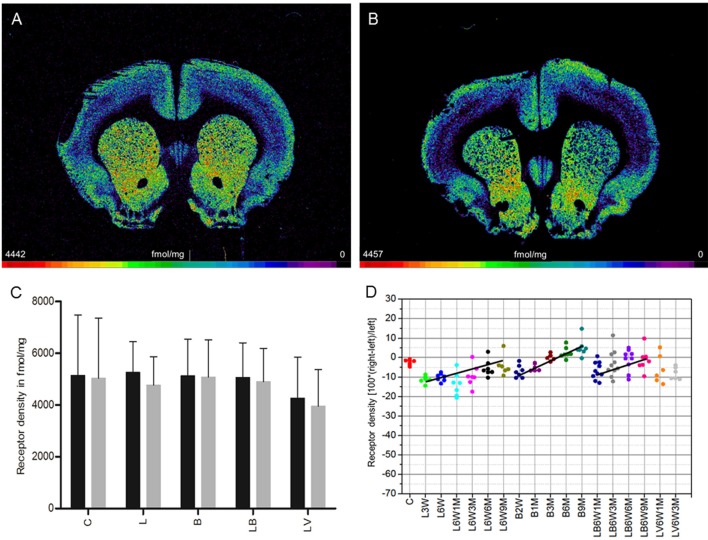
(A,B) Contrast-enhanced color-coded images showing the regional distribution of M1 receptor density labeled with [3H]pirenzepine in a control rat (A,B) after 6-OHDA lesion (group L6W1M) in a control rat (A) and after 6-OHDA lesion (group L6W1M) (B). (C) Mean receptor density (fmol/mg protein; averaged over all post-lesion survival times) in the left/contralateral (black column) and right/ipsilateral hemispheres (gray column) of the 5 groups: C, control; L, 6-OHDA lesion; B, BoNT-A only; LB, L + BoNT-A; LV. L + vehicle. All data is expressed as means ± SD. (D) Scatter plots and regression analyses of the right-left differences of M1 receptor density for all 18 groups and time points (five groups with different survival times); see Table 1 for explanation of abbreviations. Significant regressions are labeled by a continuous line.